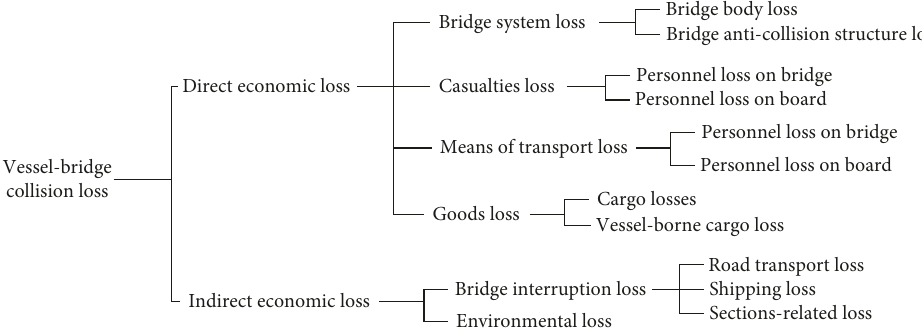
Figure 6: Classification of vessel-bridge collision loss